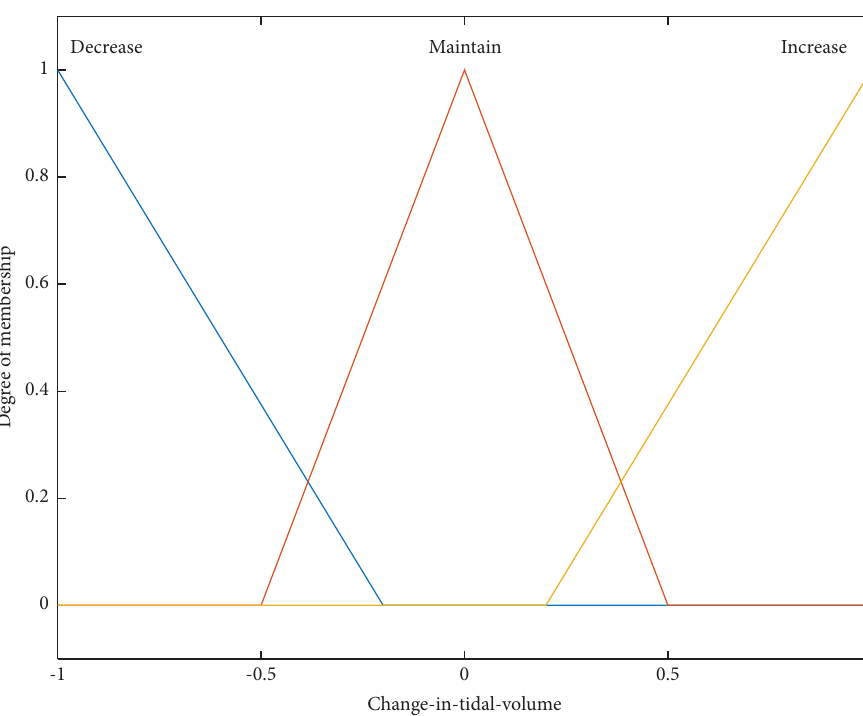
Figure 8: Membership function for change in tidal volume